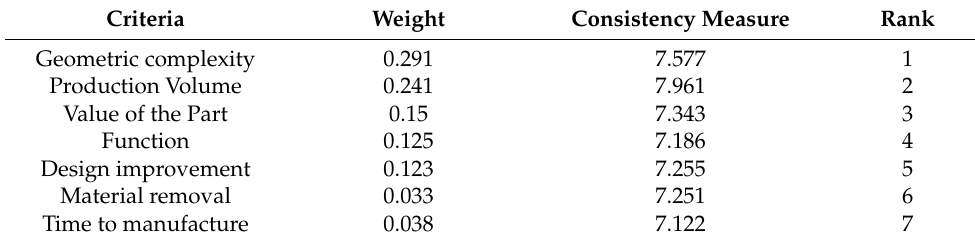
Table 8. Criteria weights.